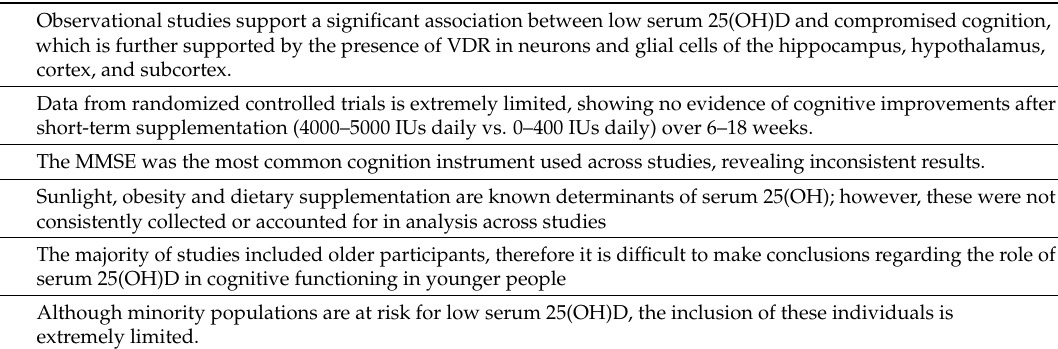
Table 4. Key points regarding serum 25(OH)D and